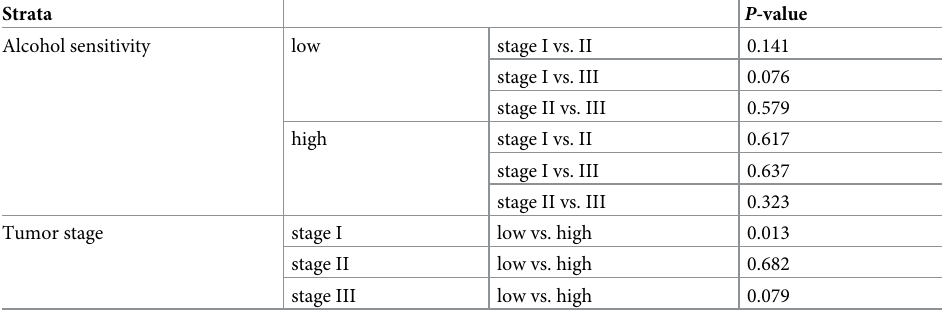
Table 5. Differences of SREs between stages in patients stratified by alcohol sensitivity and between sensitivities in patients stratified by tumor stages. Strata P- value Alcohol sensitivity